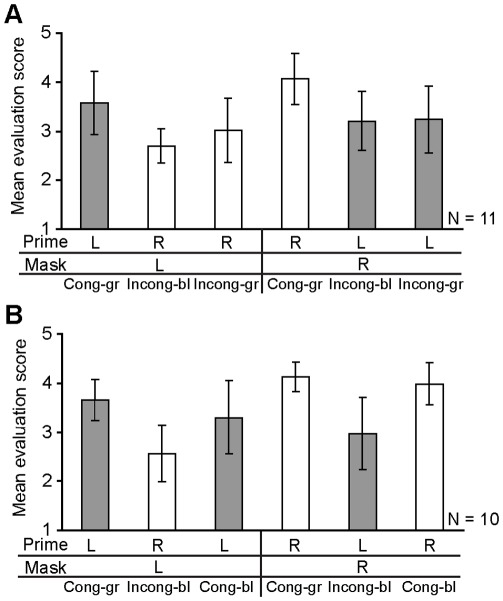
Mean evaluation scores in the test phase.(A) Incongruent-green group and (B) congruent-blue group. Cong-gr, Incong-bl, Cong-bl, and Incong-gr denote congruent-green, incongruent-blue, congruent-blue, and incongruent-green conditions, respectively.